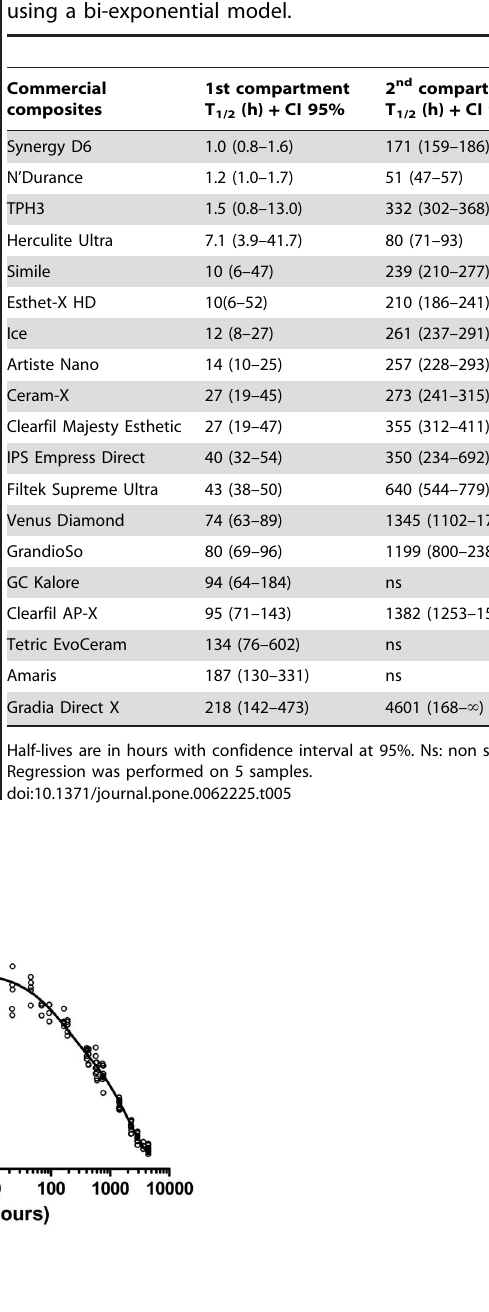
Table 5. Decay kinetics parameters for commercial resins using a bi-exponential